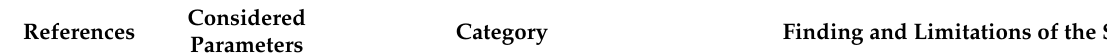
Table 1. Summary of the important related works and their